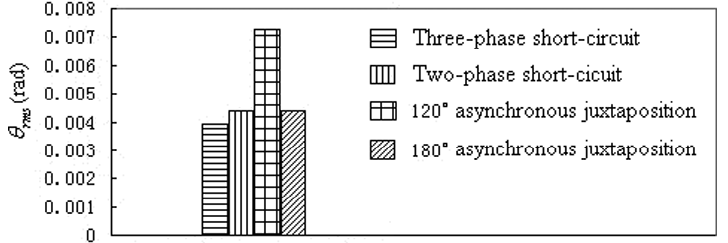
Fig. 11. Comparison between the RMS values of the torsional vibration during the network